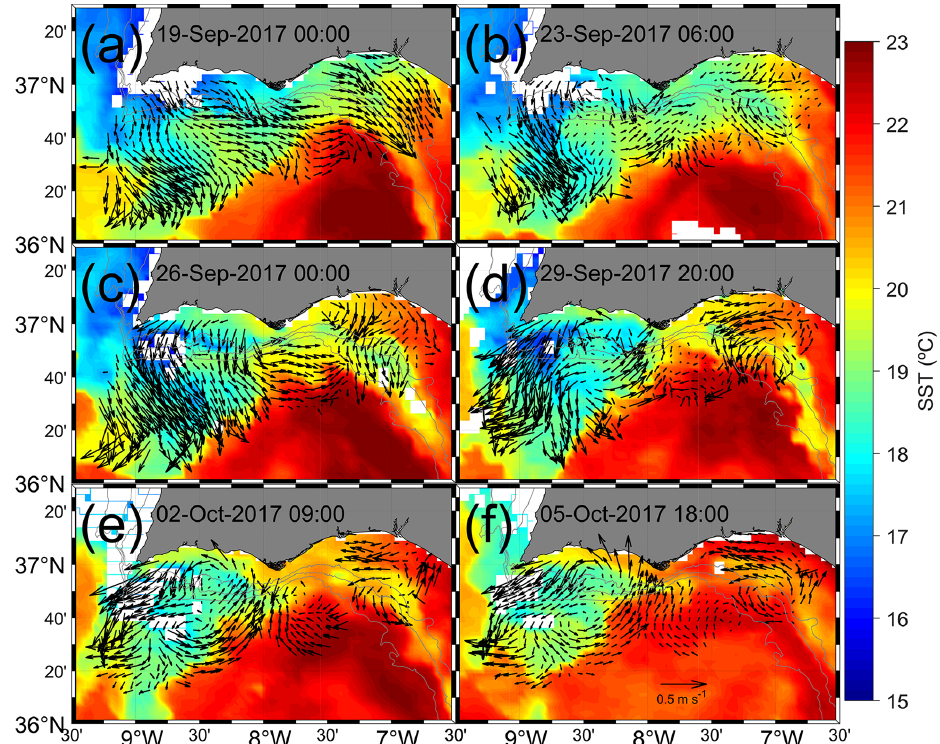
Figure 11. SST from VIIRS-SNPP (https://oceandata.sci.gsfc.nasa.gov, last access: 15 November 2021) and HFR subtidal surface currents (as arrows, the scale of which is indicated in f ). For clarity, arrows are represented every four grid nodes.